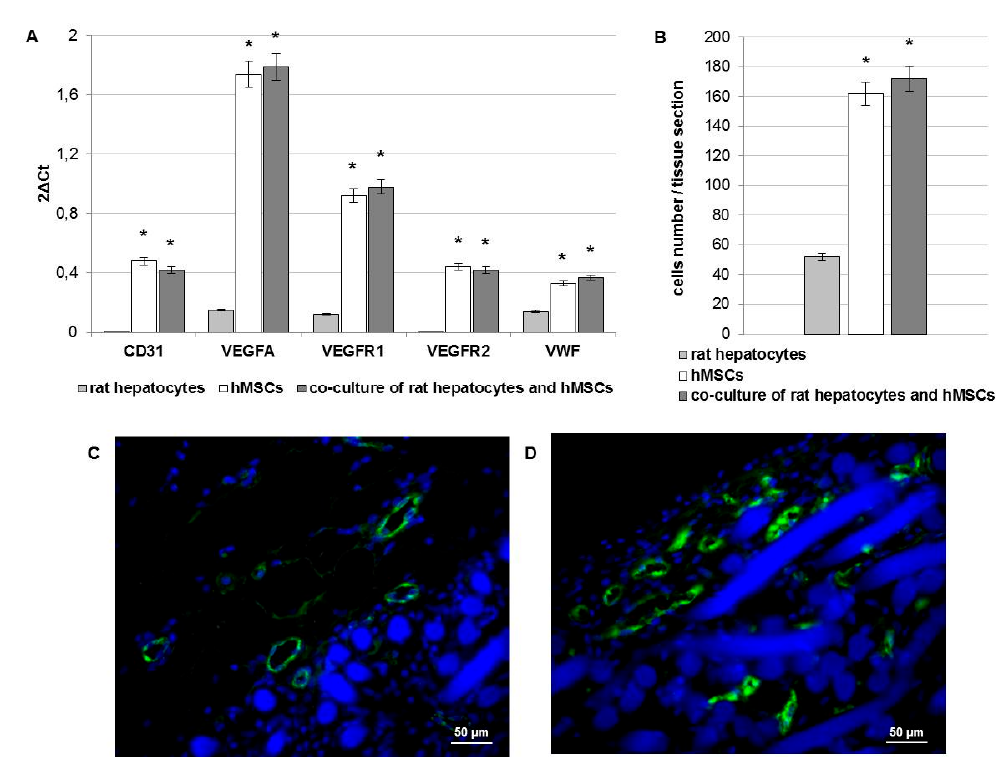
Figure 5. ( A ) Gene expression profiles of endothelial markers in pocket-scaffolds derived from 3D mono-culture of rat hepatocytes, 3D mono-culture of hMSCs, and 3D co-culture of rat hepatocytes and hMSCs at seven days from implantation in a rat model. VEGFA: vascular endothelial growth factor A; VEGFR1: vascular endothelial growth factor receptor 1; VEGFR2: vascular endothelial growth factor receptor 2; VWF: von Willebrand factor. Results are related to nine rats that have received the three different experimental set. Data presented as the mean ± standard error of three measurements. * p value ≤ 0.05.; ( B ) Semi-quantitative analysis of cells positive for VWF in pocket-scaffolds after seven days of in vivo implantation. Data are presented as the mean ± standard deviation ( n = 3 per group). * p value ≤ 0.05; ( C , D ) Immunofluorescence staining of VWF (green) in pocket-scaffold enriched with rat hepatocytes and hMSCs displaying VWF positivity both in the edge and within the pocket-scaffold. Nuclei (blue) stained with Hoechst.